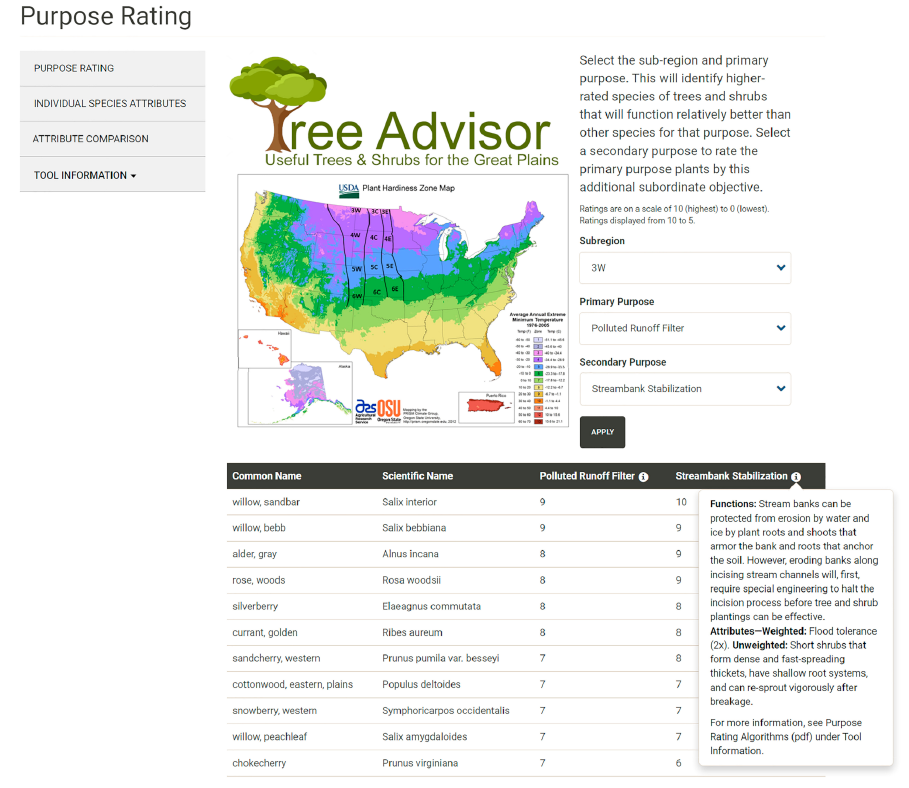
Figure 4. The Purpose Rating module in Tree Advisor allows users to select a primary and secondary purpose to rate the species in the selected sub-region. Users can run the module additional times to develop a list of potential species that can address additional purposes. Informational pop-ups provide a summary of the plant functions and attributes used to develop the rating for the